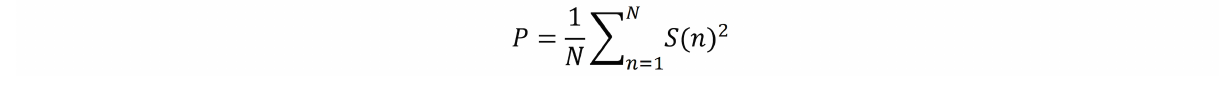
Figure 2. Location variance feature; calculated as the logarithm of the sum of variances in latitude and longitude values.